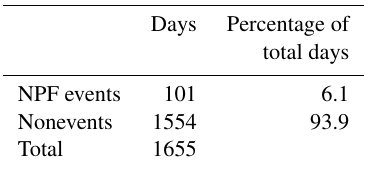
Table 2. Event statistics classified by using total concentration data obtained from two